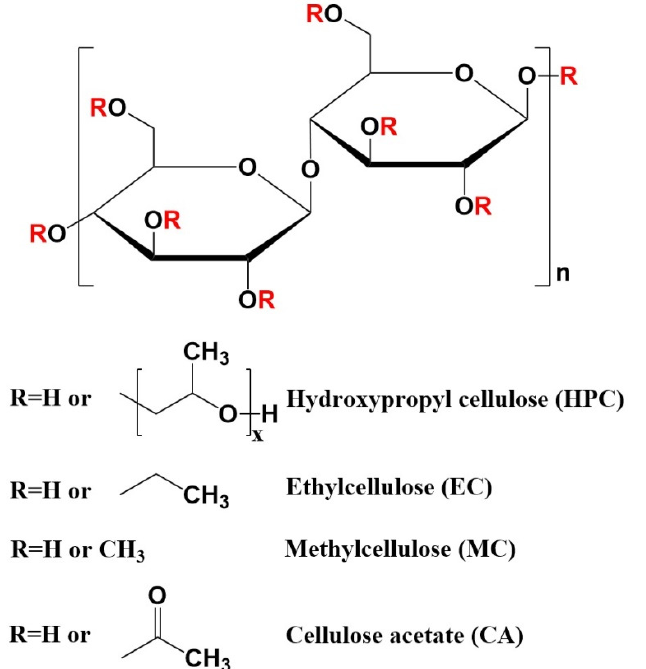
Figure 1. The cellulose derivatives used for the reduction and stabilization of silver nanoparticles (AgNPs).